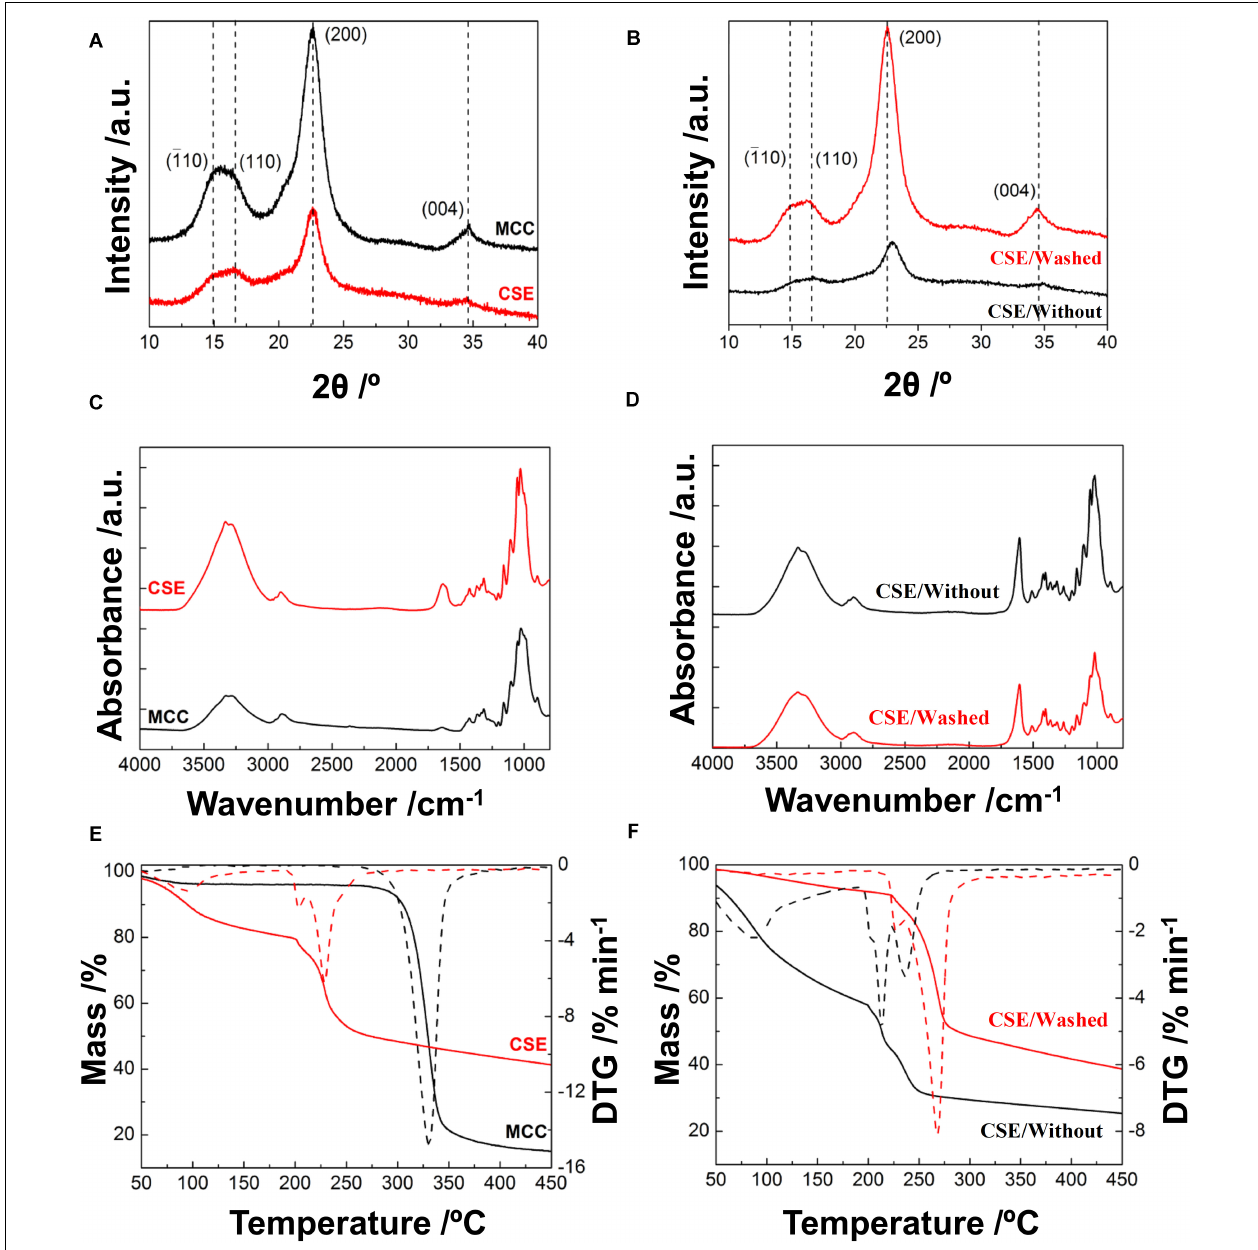
FIGURE 2 | X-ray diffraction patterns of (A) source MCC and CSE obtained using microwave irradiation and (B) of CSE washed and obtained without microwave irradiation. FTIR spectra of (C) source MCC and CSE obtained using microwave irradiation and (D) of CSE washed and obtained without microwave irradiation. Thermogravimetric curves (solid lines) and derivative thermogravimetric curves (dash lines) of (E) source MCC and CSE obtained using microwave irradiation and (F) of CSE washed and obtained without microwave